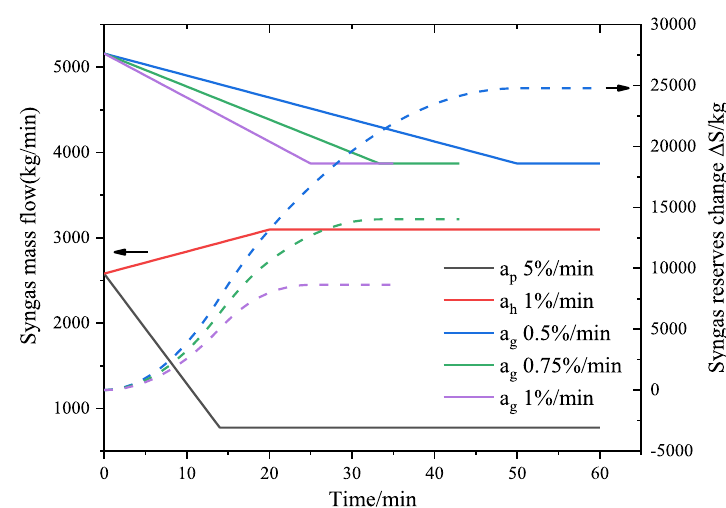
Fig. 4 Syngas reserve change with the various load change rates of the gasification